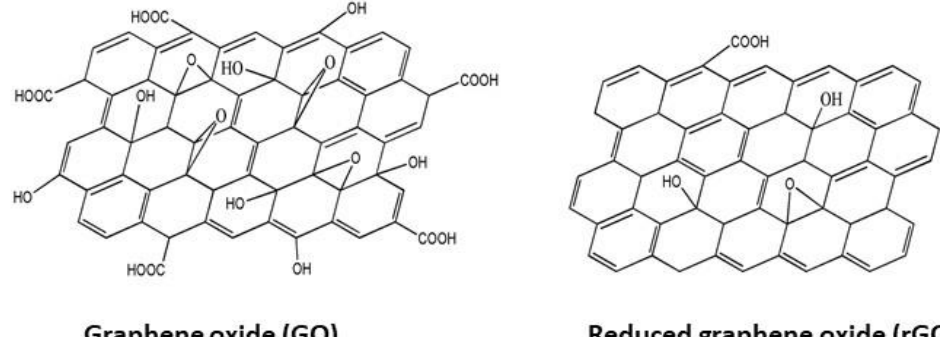
Figure 2. Representation of graphene derivatives: GO and rGO.